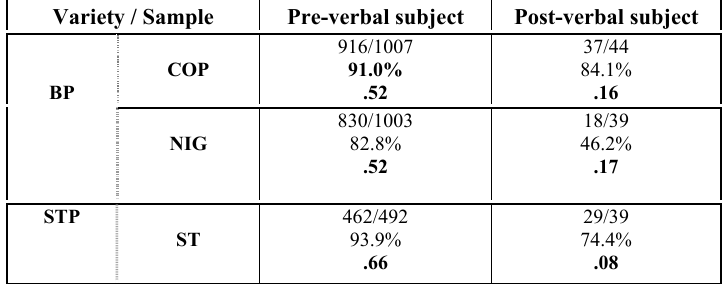
Table XIX: Third person plural verbal marking and Subject position by variety of